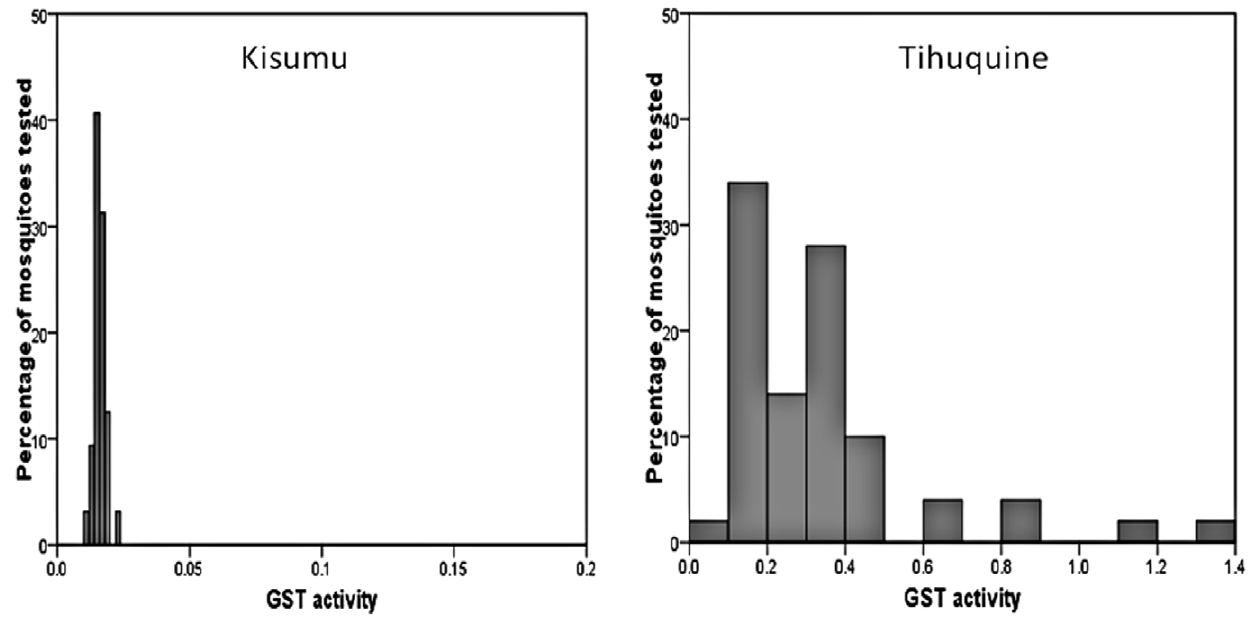
Figure 3. GST activity. Range of GST activity in the An. funestus population of Tihuquine compared with An. gambiae Kisumu reference strain.